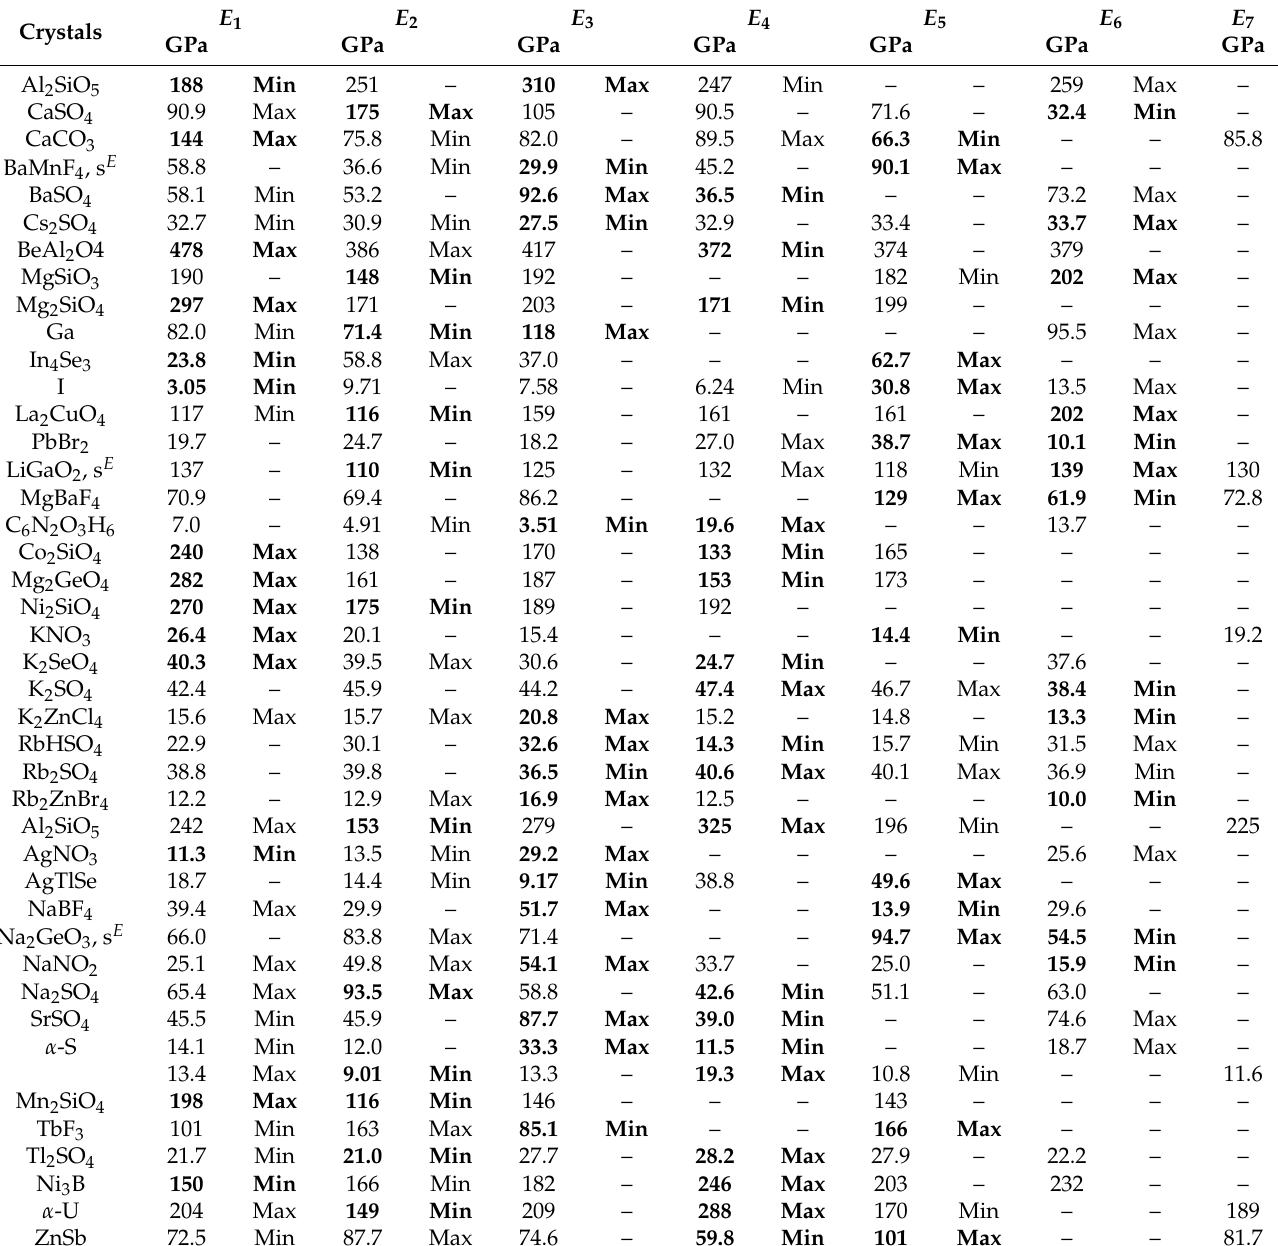
Table 2. Values of Young’s moduli E 1 , E 2 , E 3 , E 4 , E 5 , E 6 and E 7 for some rhombic crystals. Global maximum and minimum values are shown in